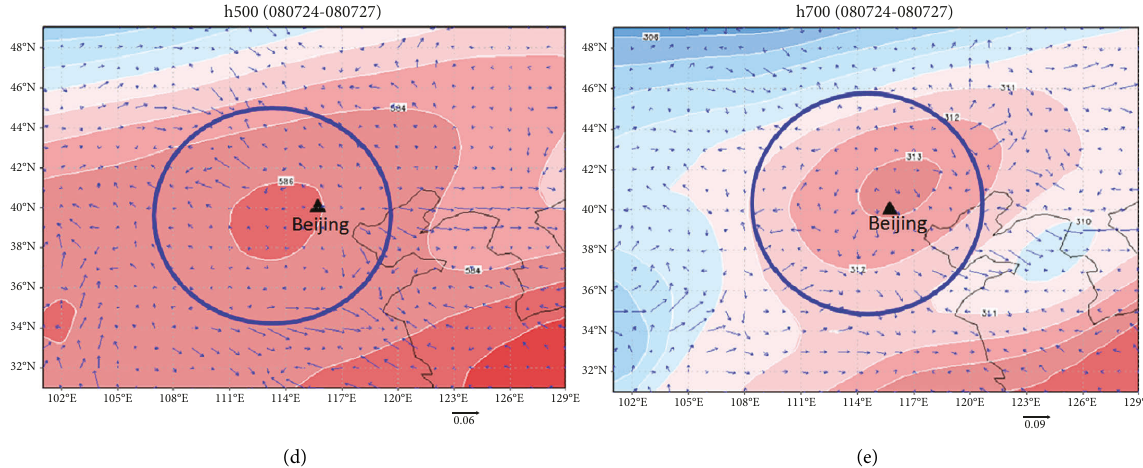
Figure 6: (a) Hourly distributions of PM 2.5 and atmospheric supersaturation (S) in 16–20 July 2018; (b) geo-potential heights (white line: gm) and saturated condensation flux ( ξ p ) at 500hPa of isobaric surfaces in the pollution process in 19–22 July 2018, (c) the same as (b) but for 700hPa, (d) the early period of 2008 Beijing Summer Olympic Games in 24–27 July 2008 for 500 hPa, (e) the same as (d), but for 700hPa; Scales of arrows are 0.005, 0.01, 0.06 and 0.09 × 10 − 3 ,respectively. Table 6: Saturated condensation flux ( ξ p ) and geo-potential heights at various isobaric surfaces over Beijing, Vancouver, and New York. Beijing Vancouver New York Isobaric surface (hPa)